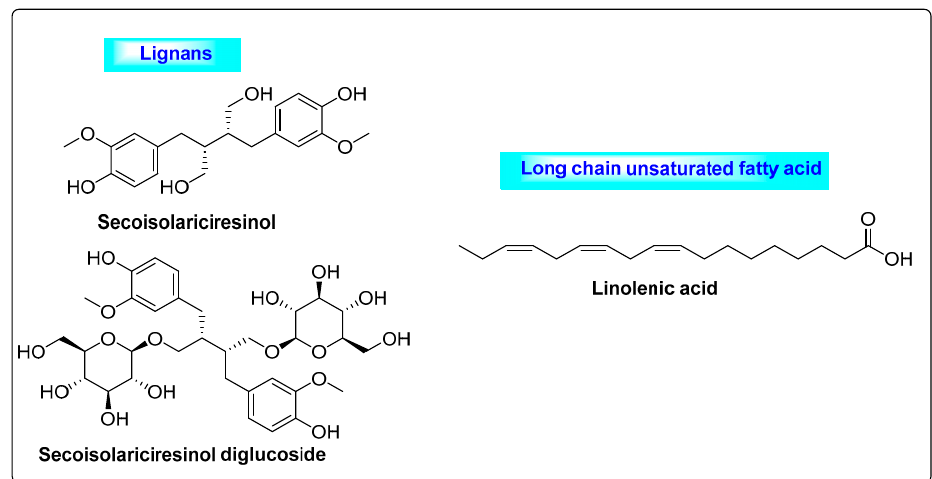
Figure 7. Lignans and polyunsaturated fatty acids present in Linum usitatissimum with anti-andro- genic